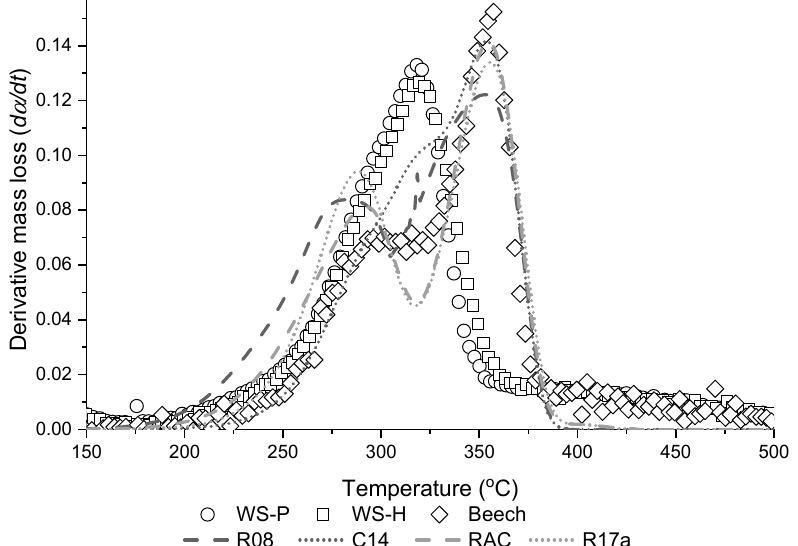
Figure 7. Comparison of the experimental degradation (above: mass loss; below: derivative) curves with the network curves with the lowest deviations towards WS-H. R08 = Ranzi et al. [12]; C13 = Corbetta [20]; RAC = Anca-Couce and Scharler [13,24]; and R17a = Ranzi et al. [21]. Influence of Potassium Content on the Pyrolysis of Cellulose Trendewicz et al. [26] proposed alternative kinetic parameters for the degradation of active cellulose and the charring of crystal cellulose depending on the potassium content of the feedstock. For the best four cases in Table 12, the original cellulose degradation networks were partially replaced with the Trendewicz model, of which the deviations from the experimental results are shown in Table